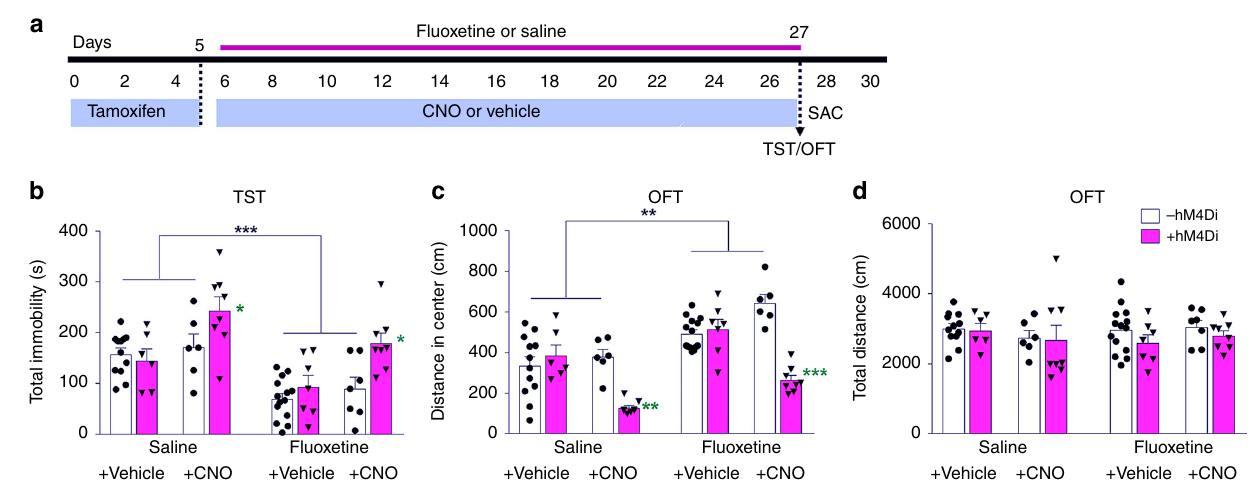
Fig. 1 Silencing newborn dentate gyrus neurons prevents the effects of fl uoxetine and alters baseline affective behavior. a Timeline representing the experimental design for determining whether silencing of newborn neurons inhibits the effects of fl uoxetine treatment in Ascl1-CreER TM ;R26 LSL − hM4Di mice. b Total time-spent immobile in tail suspension test, a measure of depression-like behavior (Fluoxetine F 1,60 = 23.11, *** P < 0.0001; hM4Di F 1,60 = 6.92, * P = 0.011; CNO F 1,60 = 15.60, *** P < 0.0001; hM4Di*CNO F 1,60 = 5.08, * P = 0.028; Tukey posthoc test + hM4Di + CNO Saline treatment versus other saline treatment groups * P < 0.05; + hM4Di + CNO Fluoxetine treatment versus other fl uoxetine treatment groups * P < 0.05). c Distance spent in center exploration in open- fi eld test, a measure of anxiety-like behavior (Fluoxetine F 1,60 = 42.32, *** P < 0.0001; hM4Di F 1,60 = 28.59, *** P < 0.0001; CNO F = 5.27, * P = 0.025; hM4Di*CNO F = 44.46, *** P < 0.0001; Tukey posthoc test + hM4Di + CNO Saline treatment versus other saline treatment 1,60 1,60 groups ** P < 0.01; + hM4Di + CNO Fluoxetine treatment versus other fl uoxetine treatment groups *** P < 0.0001). d Total distance in open- fi eld test, measure of locomotor activity (Fluoxetine F 1,60 = 0.002, P = 0.965; hM4Di F 1,60 = 1.297, P = 0.259; CNO F 1,60 = 0.138, P = 0.711; hM4Di*CNO F 1,60 = 0.030, P = 0.862). Data are presented as means ± s.e.m. and analyzed by three-way